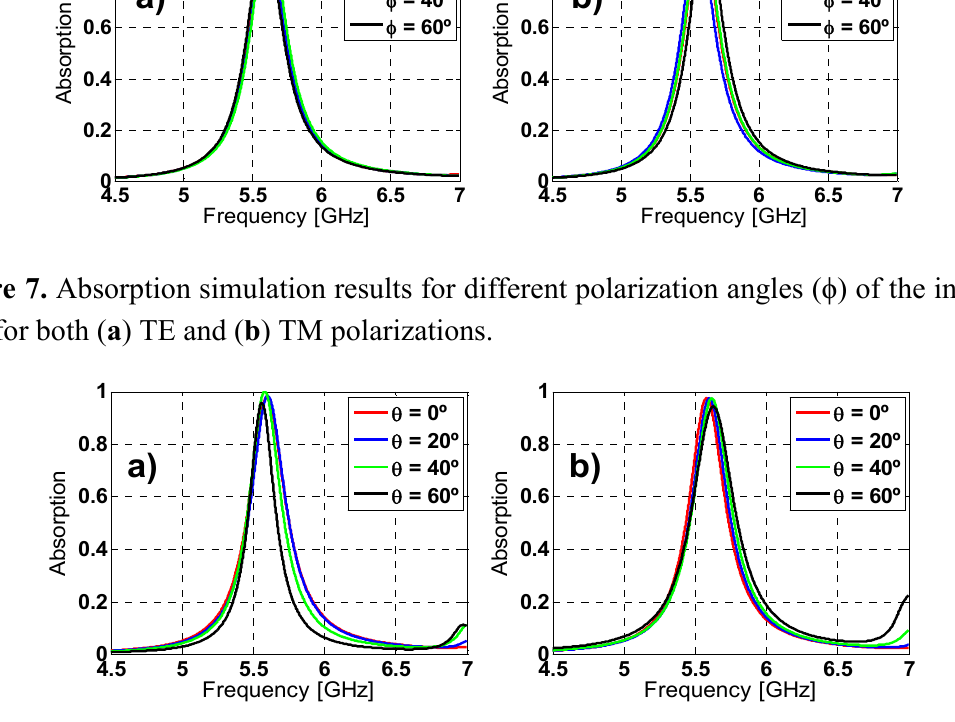
Figure 8. Absorption simulation results under different incident angles ( θ ) for both ( a ) TE and ( b ) TM polarizations.